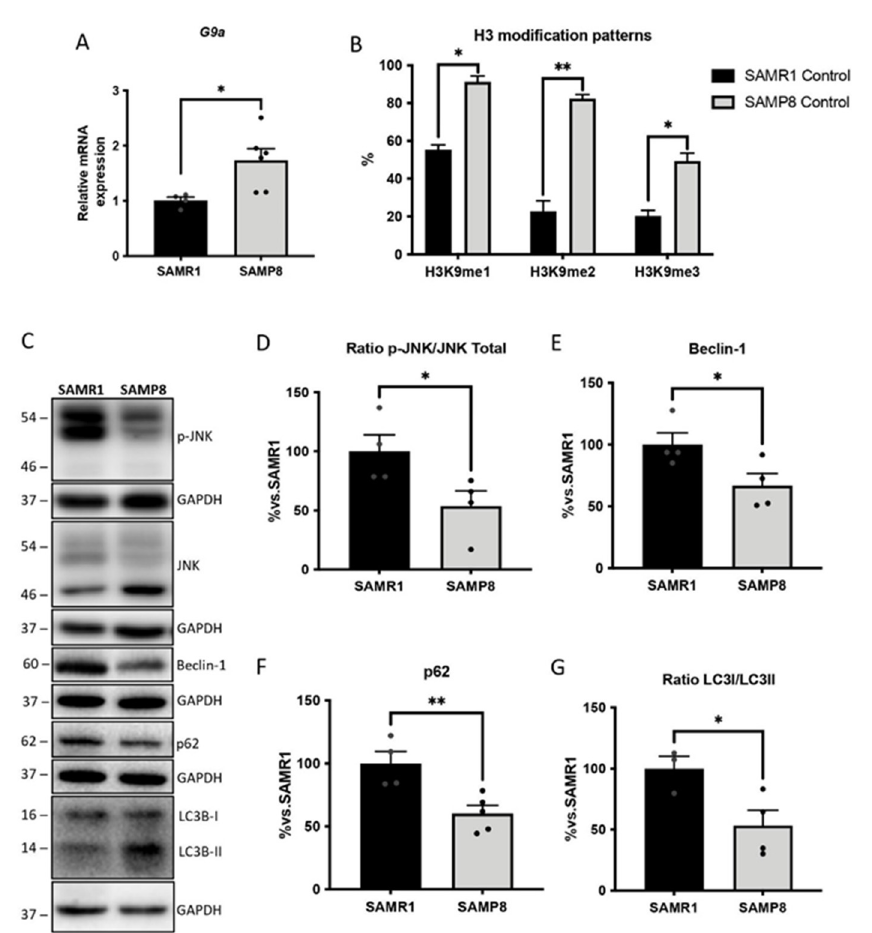
Figure 4. Representative gene expression for Ehmt2 ( A ). Gene expression levels were determined by real-time PCR. Representative global H3 modification patterns’ quantification ( B ). Bars show the mean ± SEM (n = 4–6 mice per group); * p < 0.05; ** p < 0.01. Representative WBs ( C ) and quantification for the ratio of p-JNK/JNK total ( D ), Beclin-1 ( E ), p-62 ( F ) and the ratio of LC3I/LC3II ( G ). Values in the bar graphs are adjusted to 100% for the protein levels of the SAMR1 group. Bars show the mean ± SEM (n = 3–5 mice per group). Statistical test: t-Student analysis. * p < 0.05; ** p < 0.01.